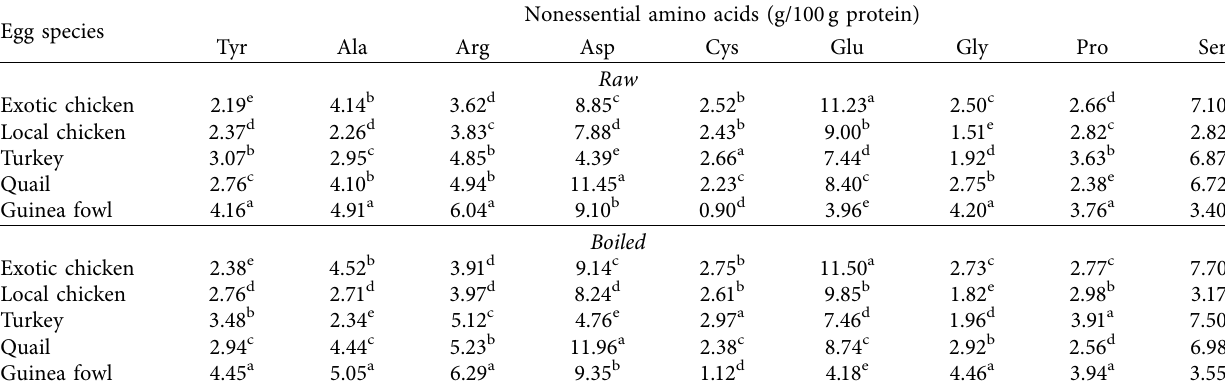
Table 2: Nonessential amino acid composition of raw and boiled egg varieties.